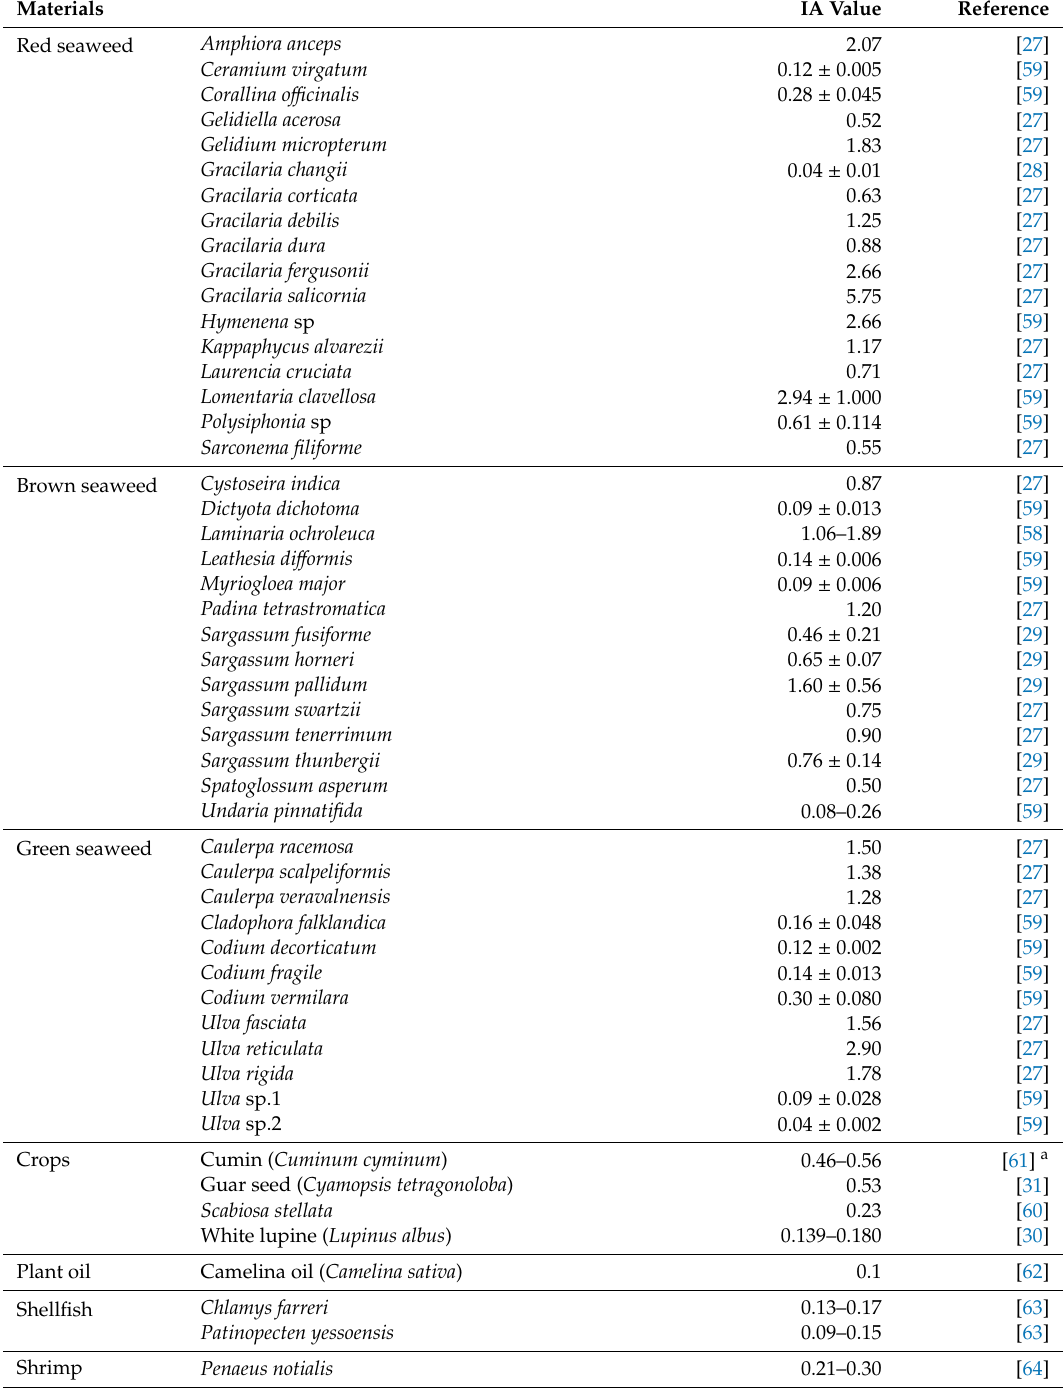
Table 4. Application of IT in fatty acid evaluation